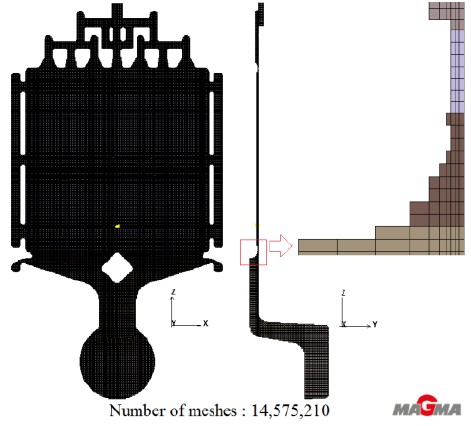
Figure 3. Mesh of die cavity with four mazes (unit: